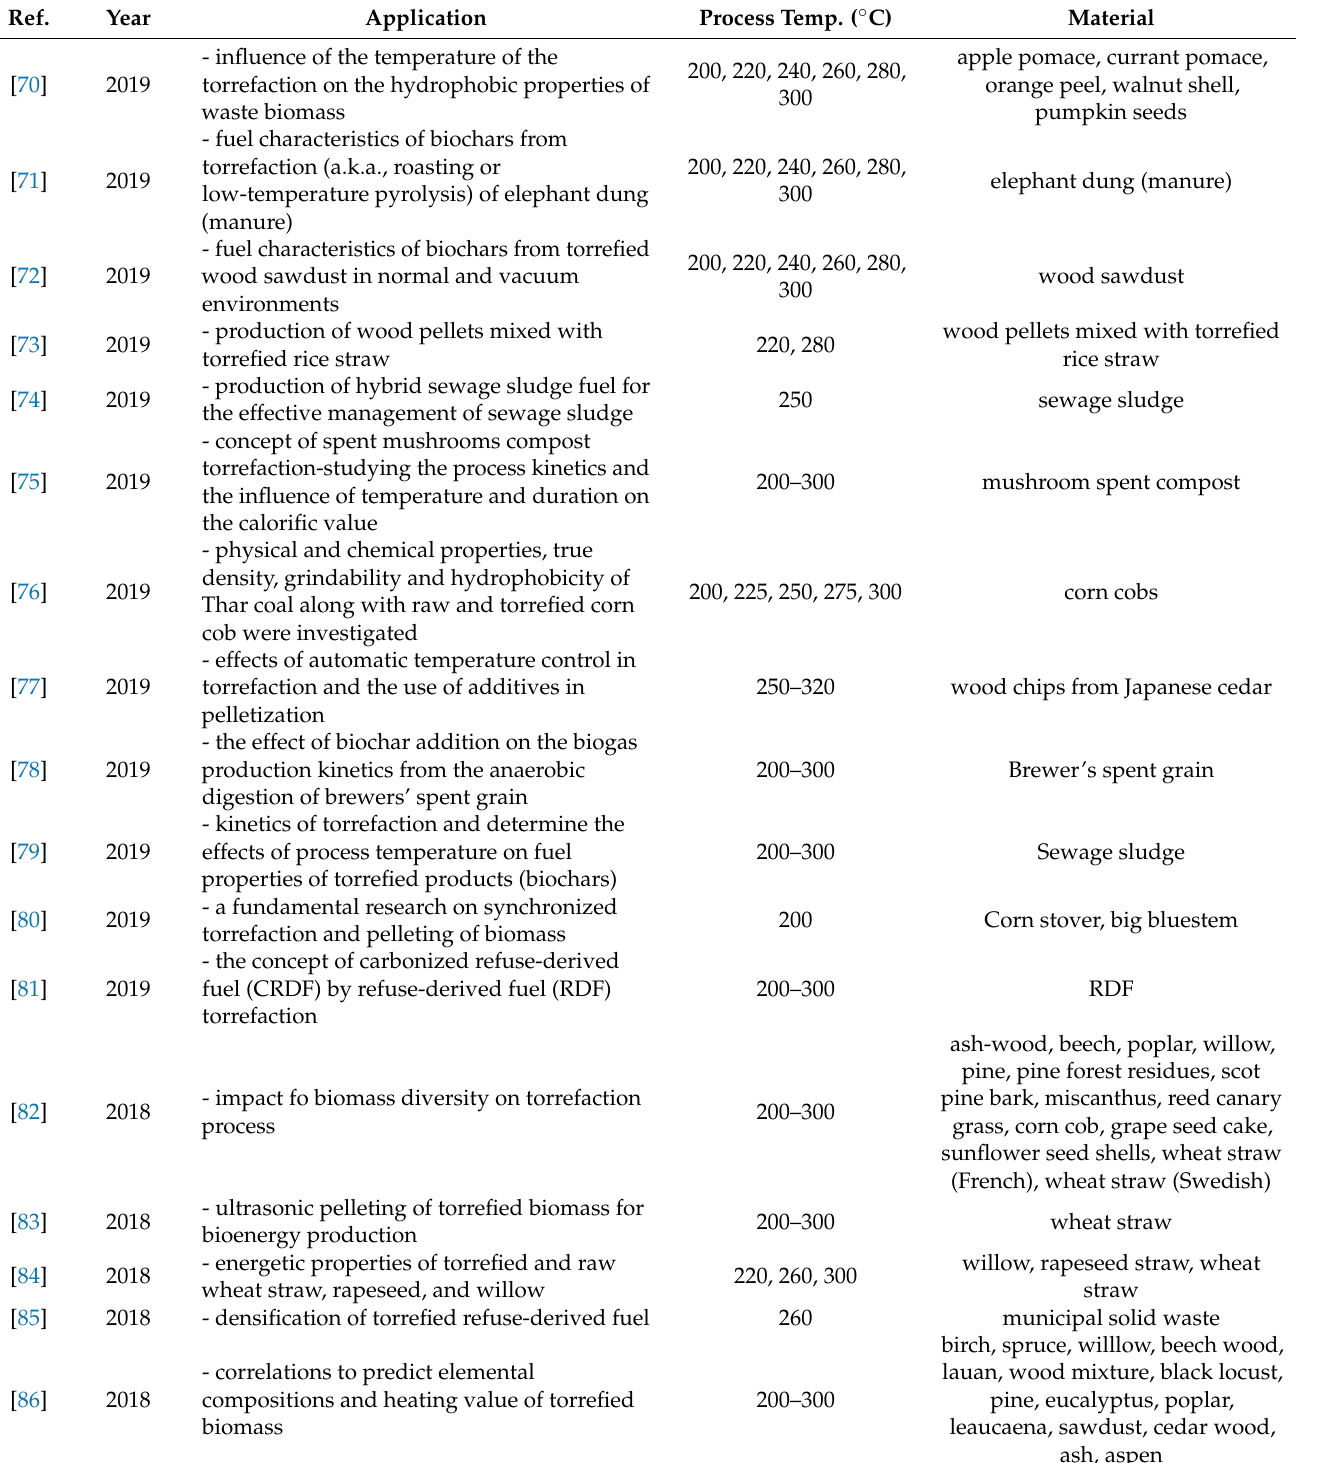
Table A1. Torrefaction process—detailed thematic